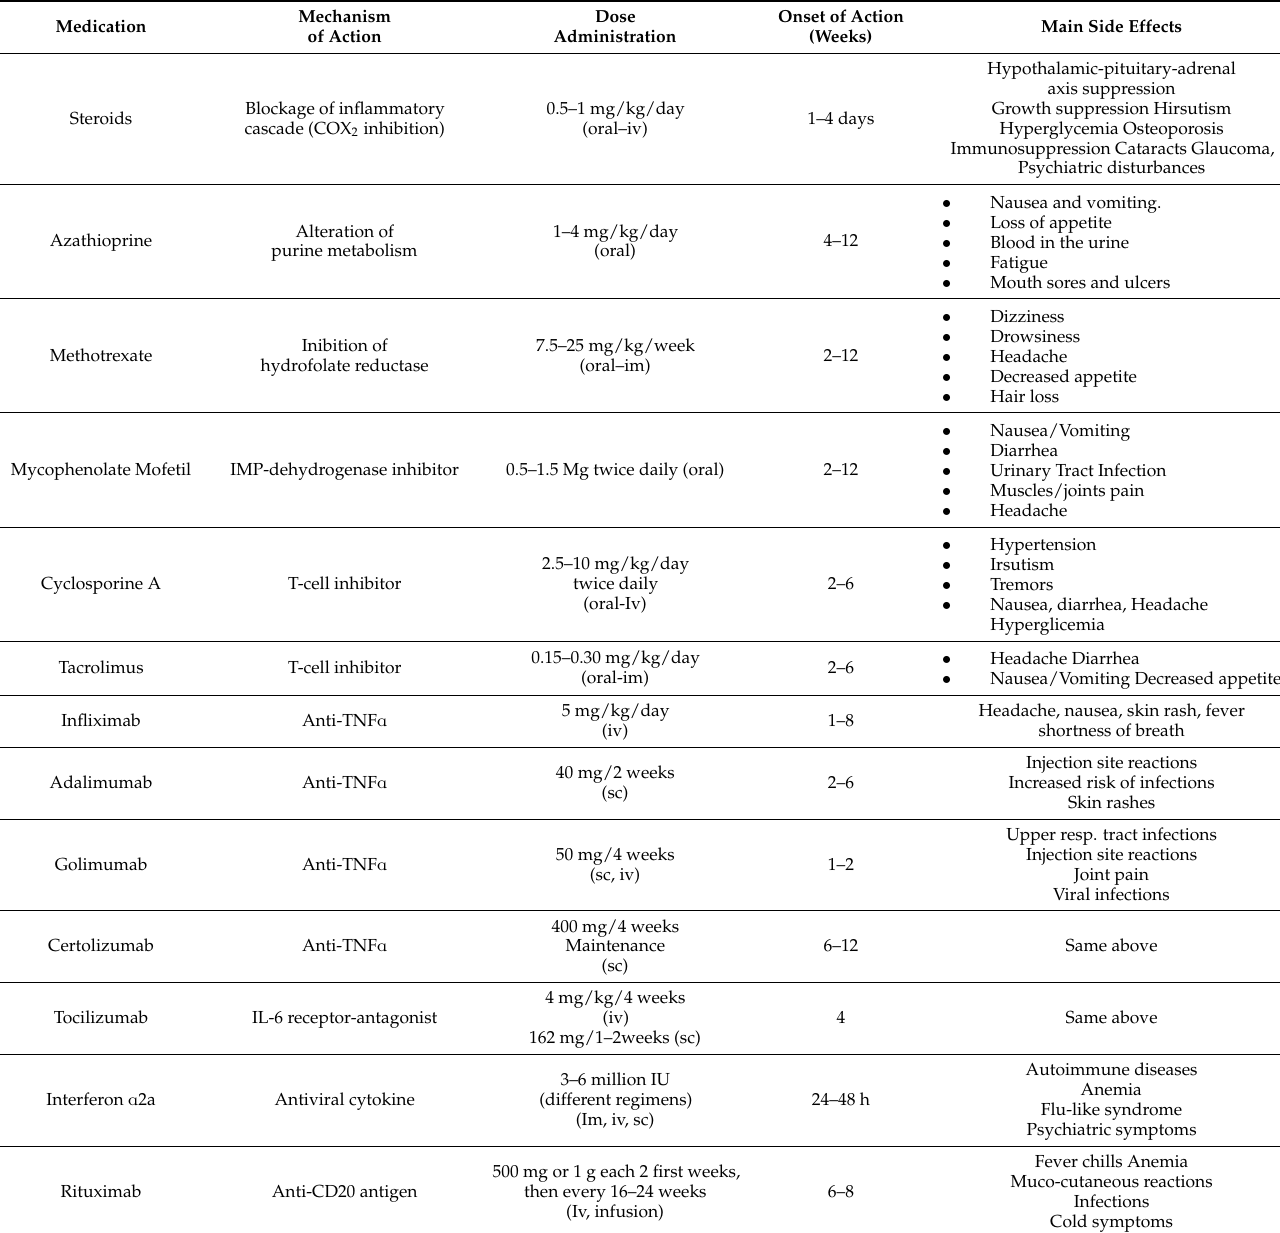
Table 2. Systemic therapies for OS complications and posterior involvement (drug, mechanism of action, dosage, way of administration, onset of anti-inflammatory action, main side-effects)